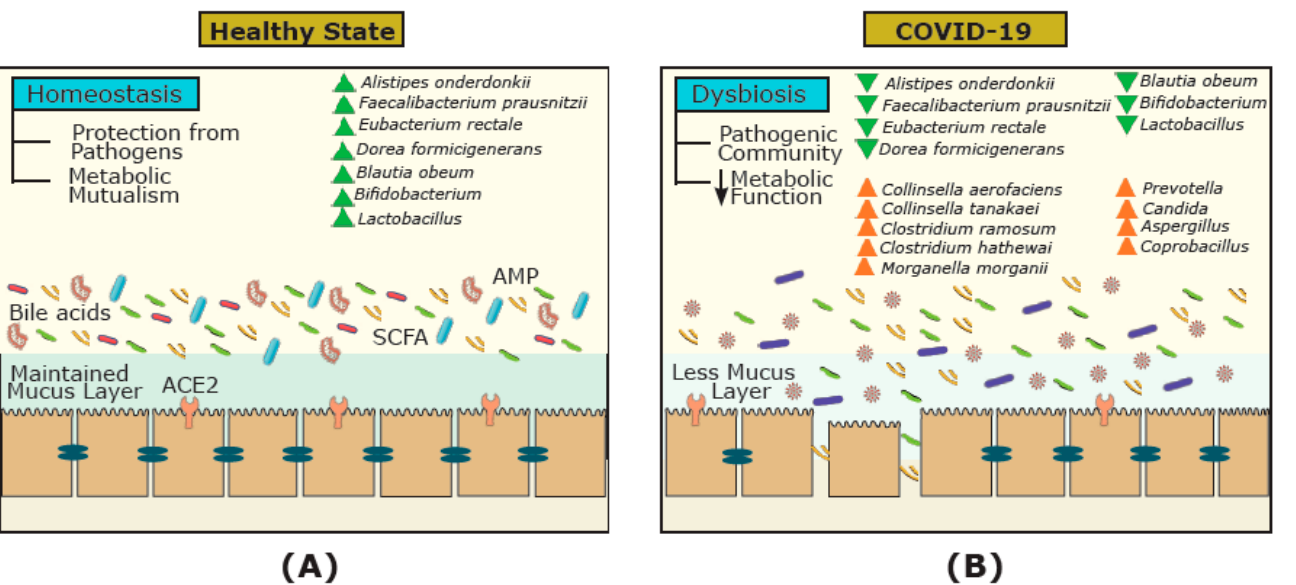
Figure 3. The gut microbial ecosystem and underlying mechanisms involved in COVID-19 infection. The gut microbiota of ( A ) healthy individuals, and ( B ) COVID-19-infected individuals. In healthy individuals, the gut harbors diverse communities and metabolites (e.g., short chain fatty acids (SCFAs) and bile acids) that vary from the gut microbial communities of COVID-19-infected individuals. During COVID-19, the dysbiosis of the gut microbial ecosystem, the reduction in metabolites involved, and downregulation of angiotensin-converting enzyme 2 (ACE2) receptors can affect the immune system (e.g., reduction in antimicrobial peptides (AMPs)) and worsen conditions.